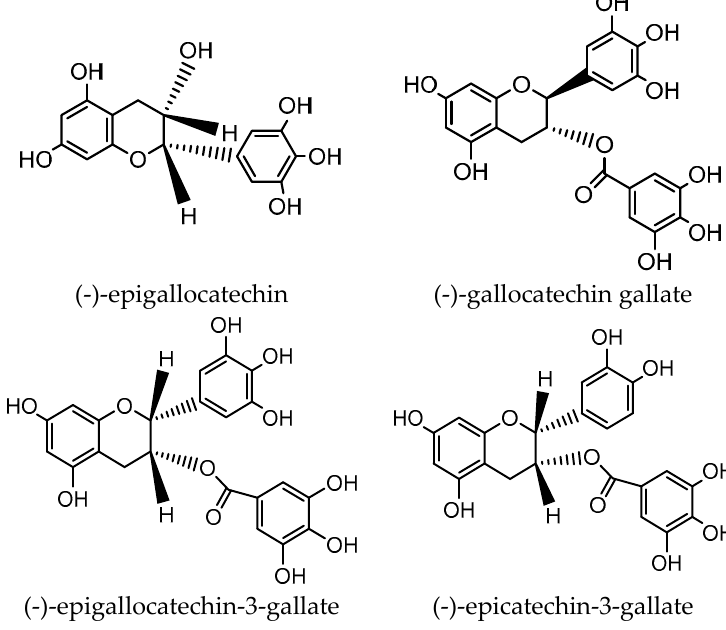
Figure 1. Chemical structures of main catechins in tea.